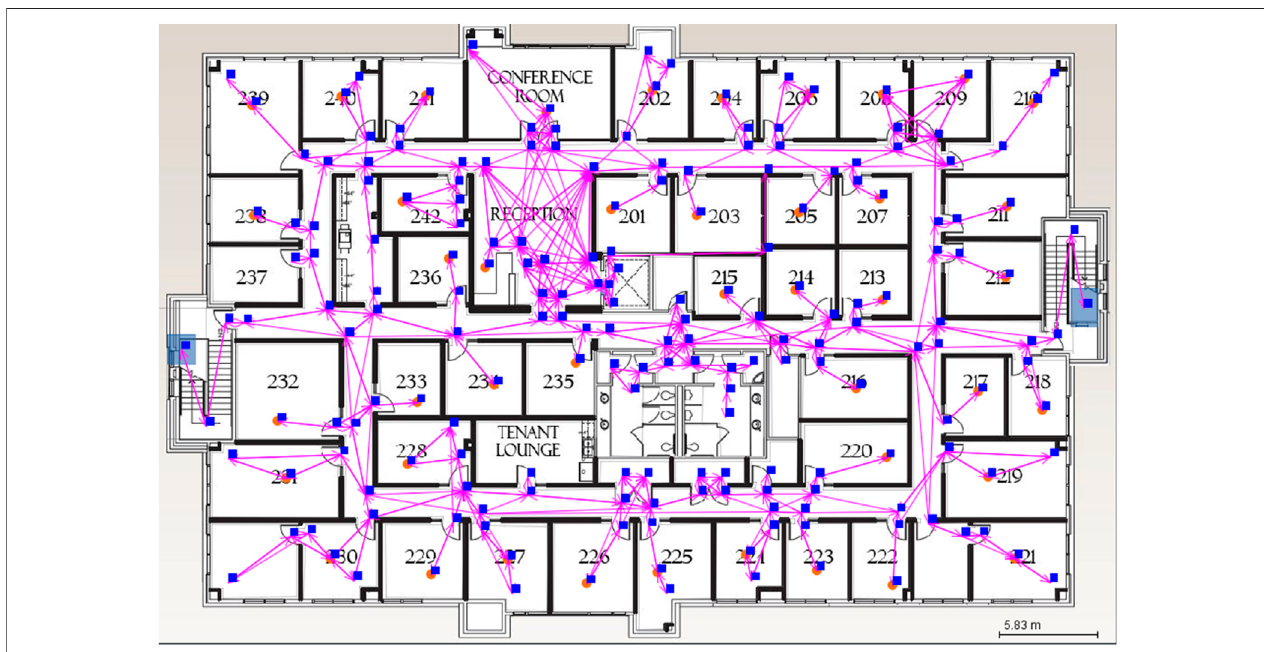
FIGURE 5 | Generation of a navigation graph from building geometry (Kneidl et al., 2012).